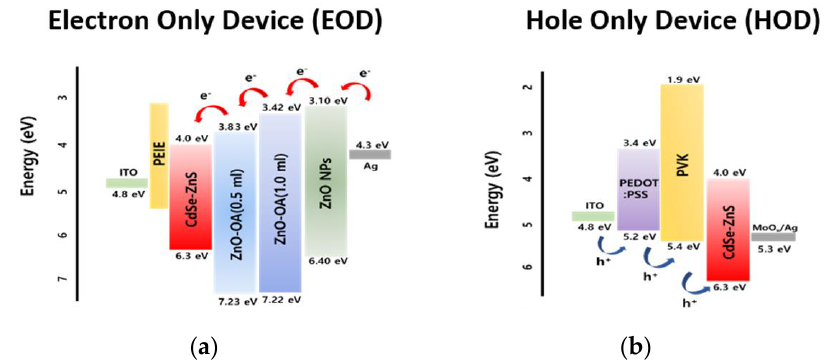
Figure 2. Electron energy level diagram of ( a ) EOD and ( b ) HOD.